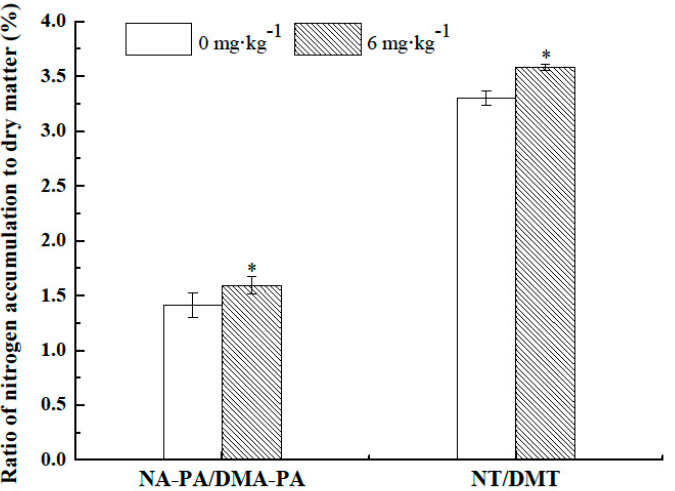
Figure 4. E ff ects of nanochitin on the ratio of N accumulation to dry matter in post-anthesis and transported from pre-anthesis vegetative organs. NA-PA: the N accumulation in post-anthesis period, DMA-PA: the dry matter accumulation in post-anthesis period, NT: the N translocation, and DMT: the dry matter translocation. Error bar represents significant differences at p ≤ 0.05.